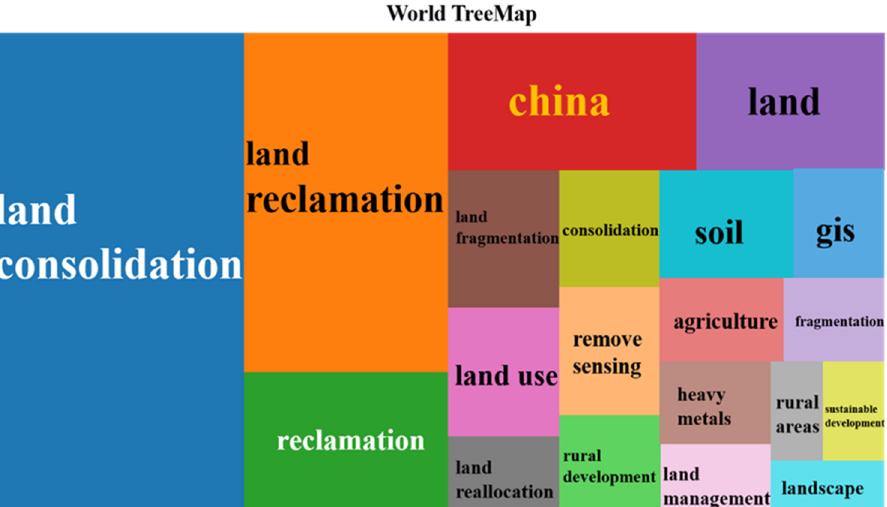
Figure 10. Word treemap of high-frequency keywords in the field of land